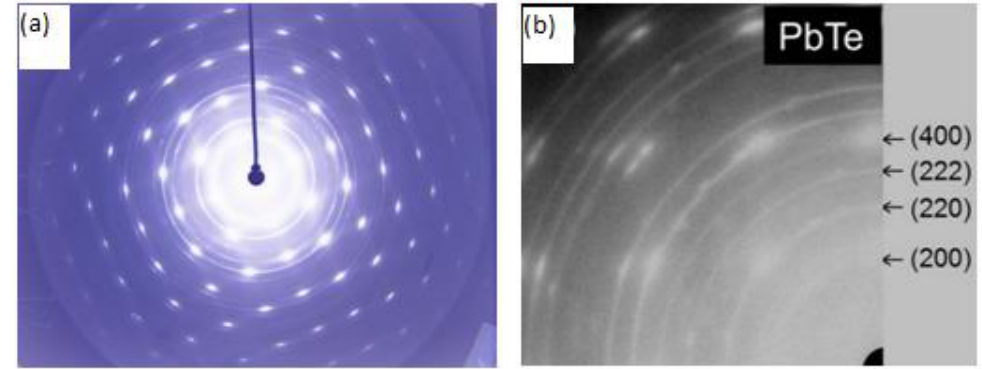
Figure 10. THEED patterns of ( a ) PbTe:In and ( b ) PbTe. The most pronounced Miller indices (hkl) are indicated.